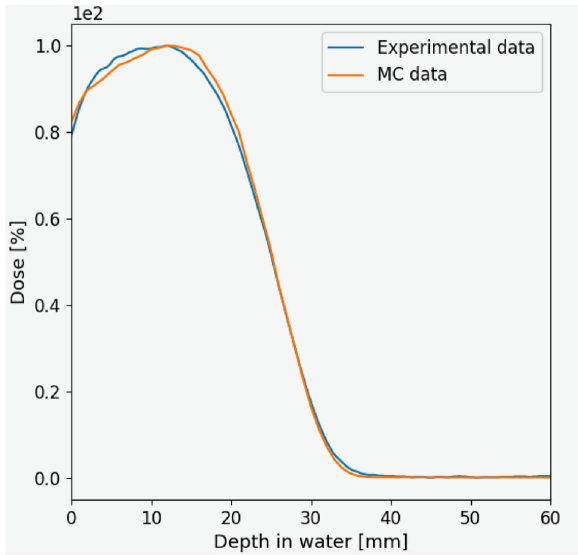
FIG. 20. Depth-dose curves for the 7 MeV electron beam; simulation data (red) and experimental data